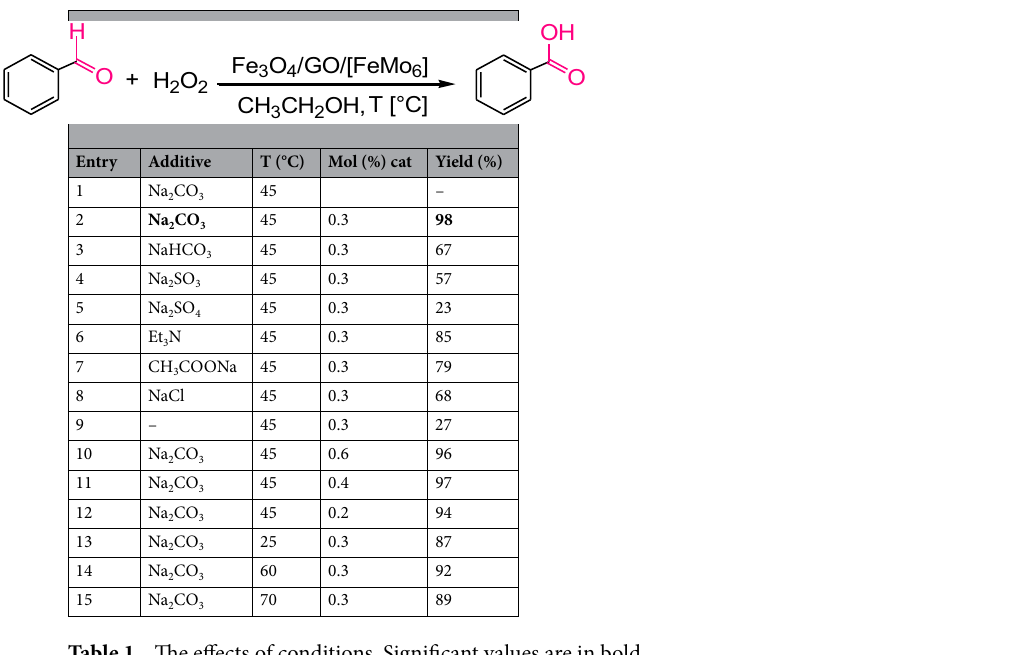
Table 1. The effects of conditions. Significant values are in